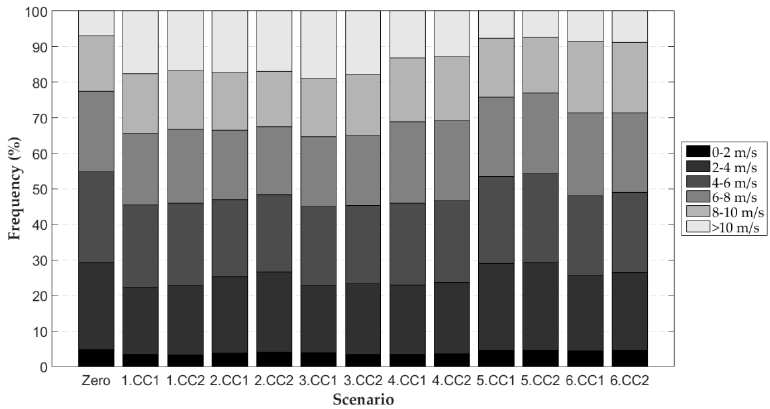
Water 2019 , 11 , x FOR PEER REVIEW Figure 3. Wind speed frequency under all examined scenarios for Lipsi Island. Figure 3. Wind speed frequency under all examined scenarios for Lipsi Island.